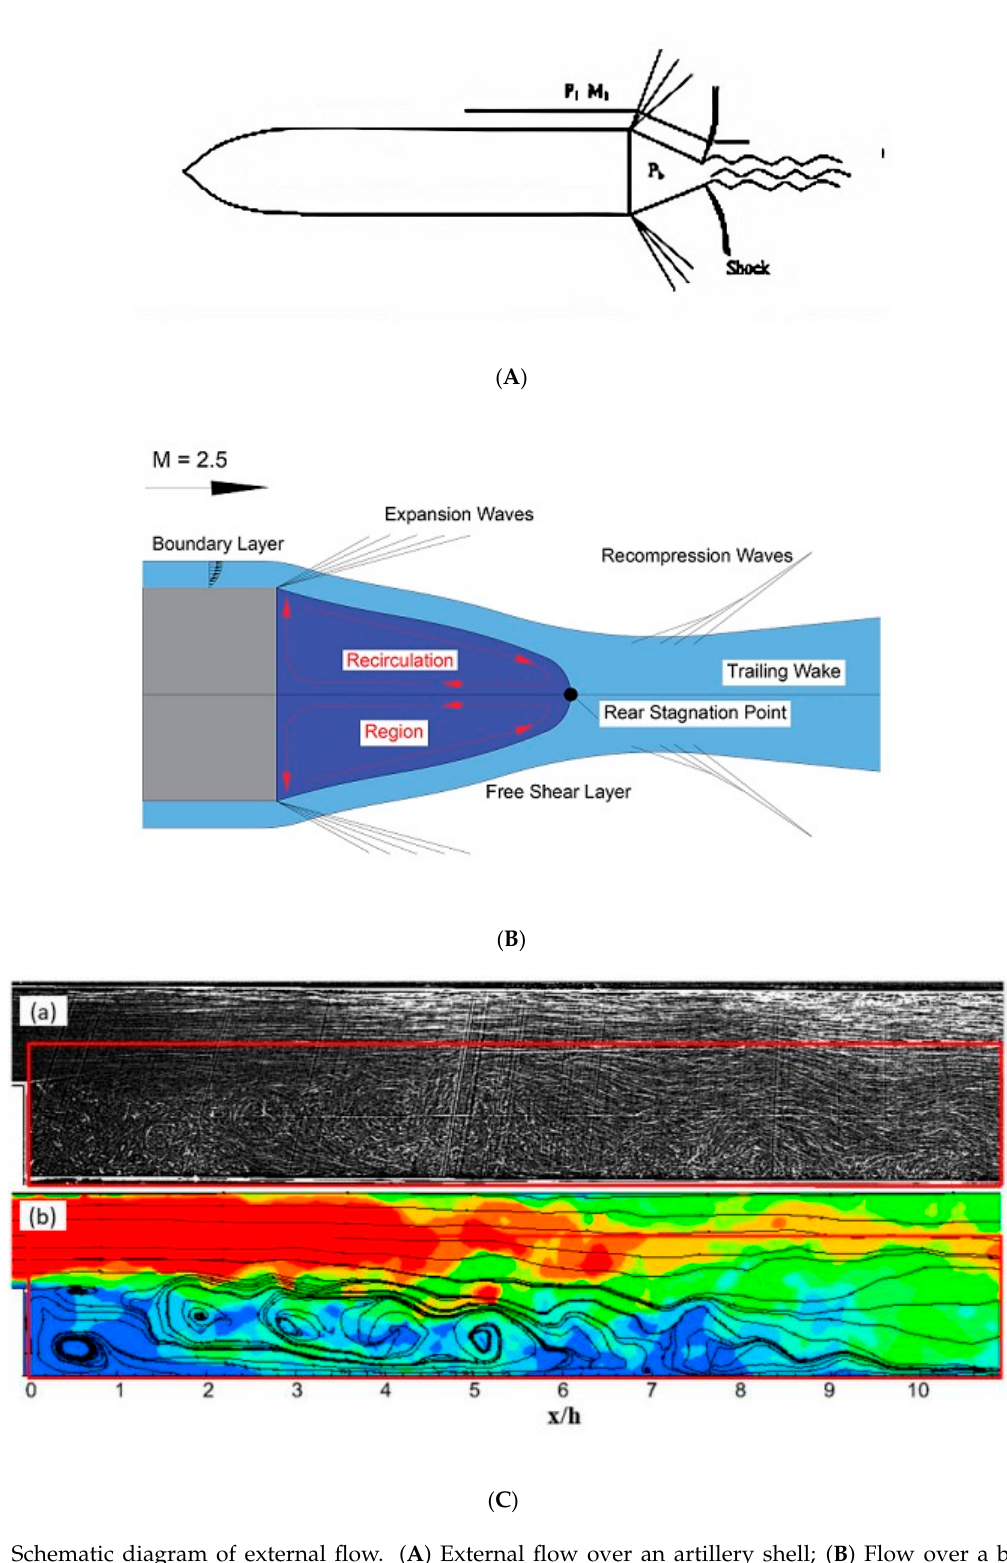
Figure 5. Schematic diagram of external flow. ( A ) External flow over an artillery shell; ( B ) Flow over a blunt base; ( C ) Coherent Vortex structures of in the instantaneous flow ( a ) Visualization ( b ) Streamlines with velocity contour [3].